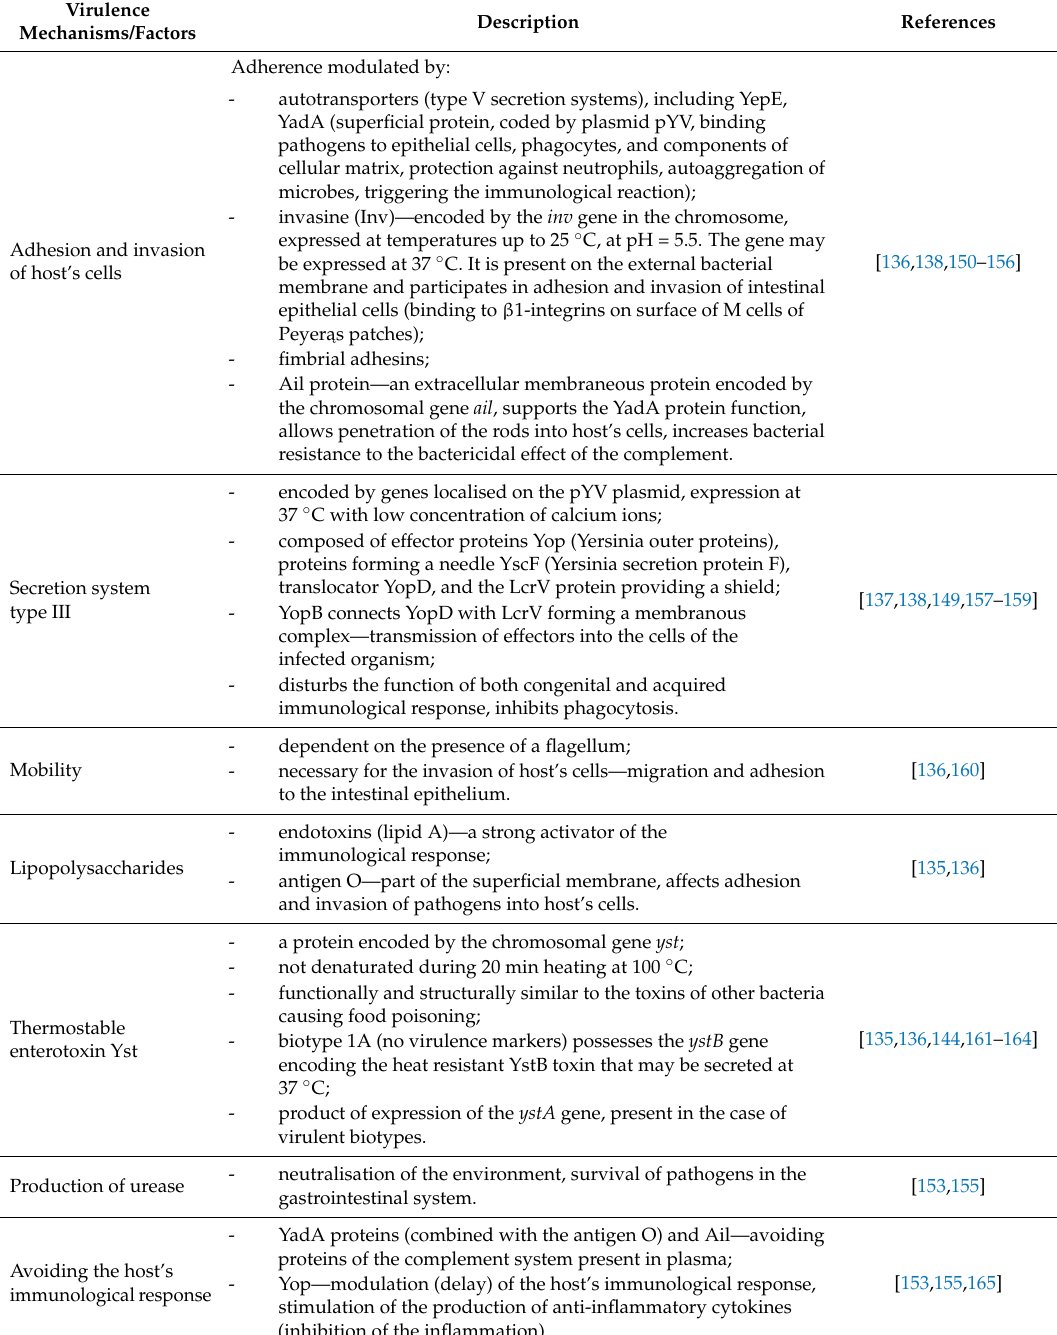
Table 4. Mechanisms and factors facilitating infection of the host’s organism with Y. enterocolitica